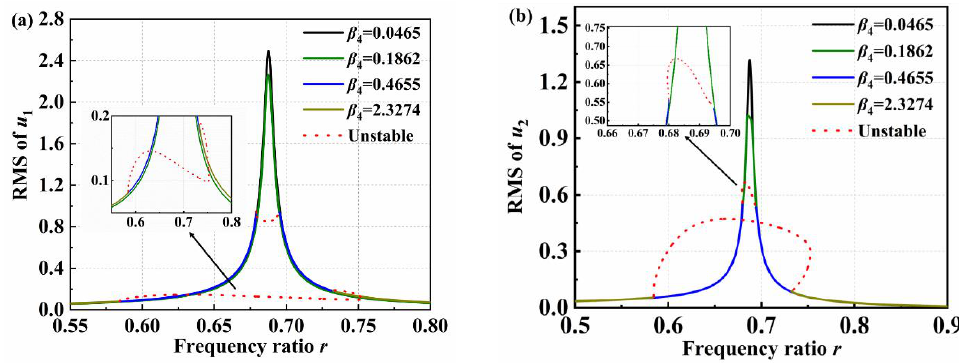
Figure 4. The root-mean-square with the different negative stiffness ratio β 4 : ( a ) u 1 ; ( b ) u 2 .